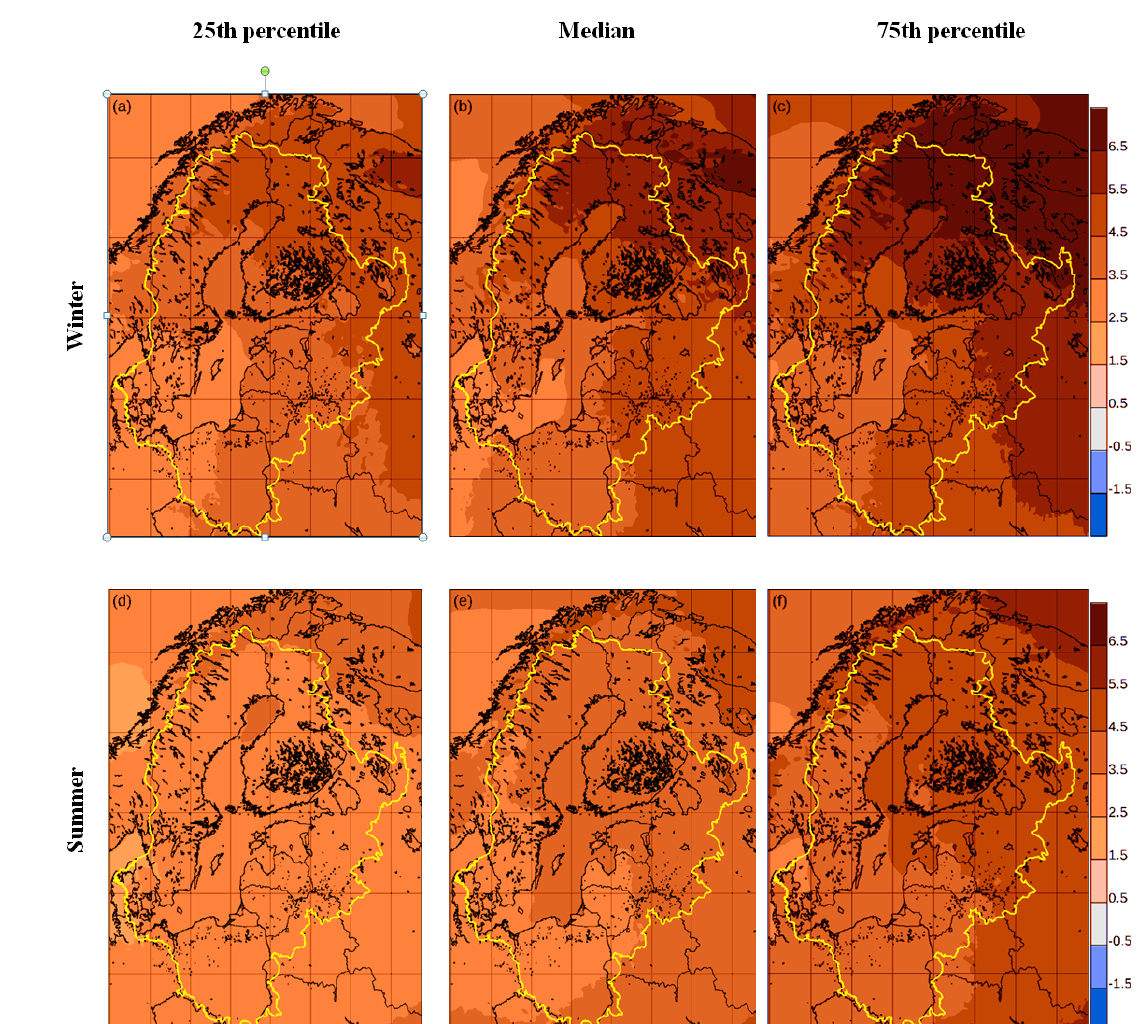
Figure 1. Temperature change between 1981–2010 and 2071–2100 for 72 simulations from EURO-CORDEX according to the RCP8.5 scenario. (a–c) Winter. (d–f) Summer. (a, d) Lowest quartile; (b, e) median value; (c, f) higher quartile. In all the following figures, panels (b, e) depicting pointwise median values are only coloured when 75% of the simulations agree on the sign of the change. The Baltic Sea catchment is indicated in